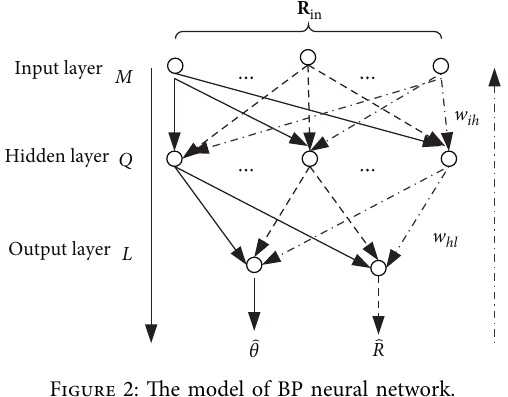
Figure 2: The model of BP neural